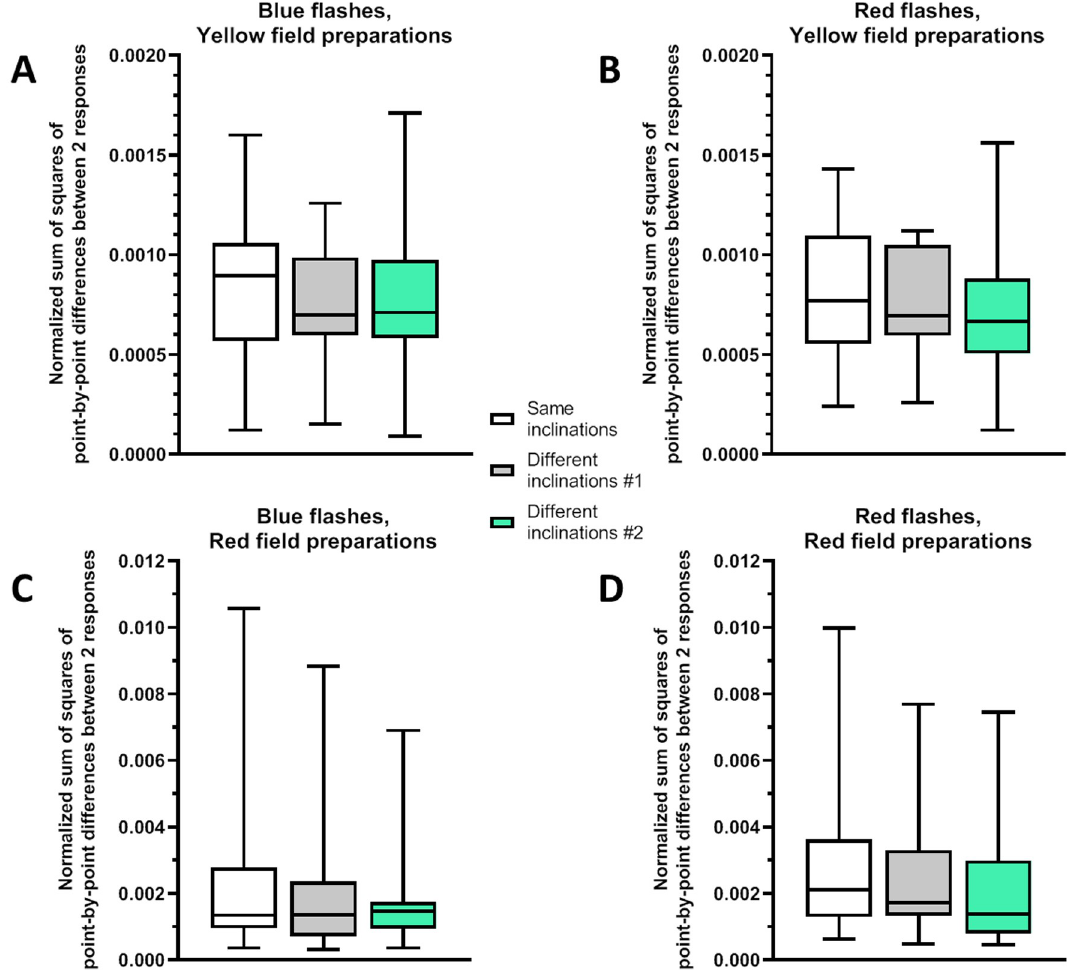
Fig 6. Analysis of potential effect of MF inclination change on the response kinetics. Y-axis shows average sums of point-by-point differences between normalized responses recorded under the same (0˚) or under two different (0˚ and 90˚) MF inclinations. Results presented for responses both to blue and red flashes. “Different inclination-1” and “Different inclination-2” refer to the sums of point- by-point differences between the responses recorded under the MF inclination 90˚ and 1st or 2nd set of responses recorded under inclination 0˚, respectively. (A) Results for yellow field preparations. n = 16 for responses both to blue and red flashes. (B) Results for red field preparations. n = 15 for responses both to blue and red flashes. For both types of retinal fields no significant changes in response maximum were detected by one-way repeated measures ANOVA. Data presented as medians (black horizontal lines) and quartiles (boxes and bars).